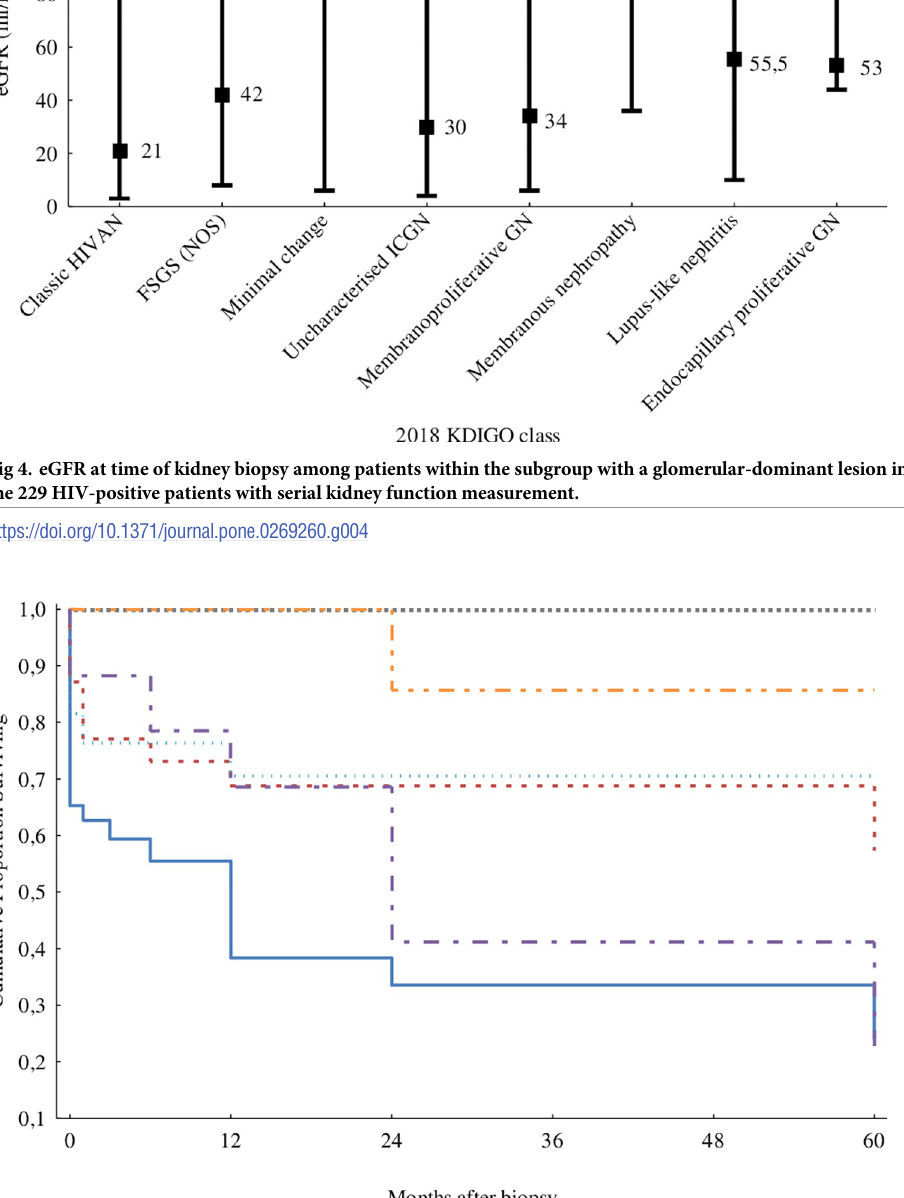
PLOS ONE | https://doi.org/10.1371/journal.pone.0269260 May 31,